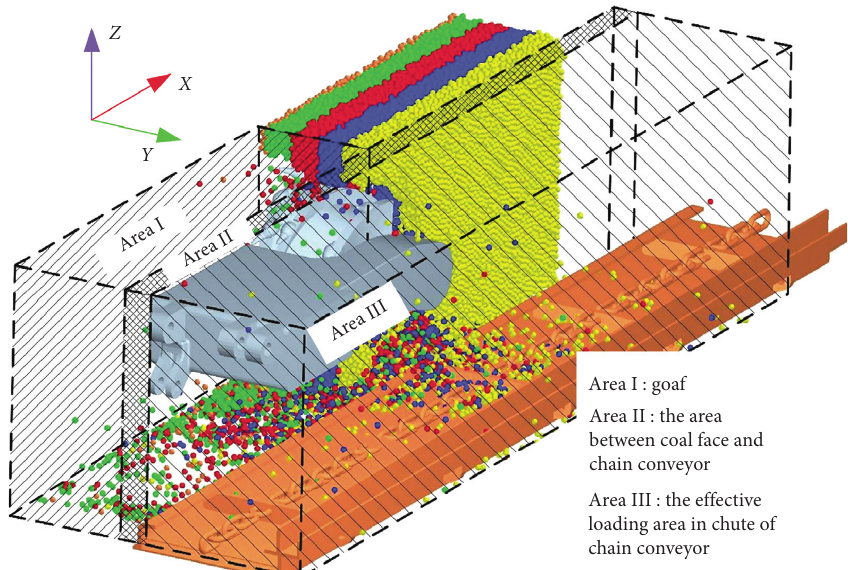
Figure 5: Statistical area division of coal loading.